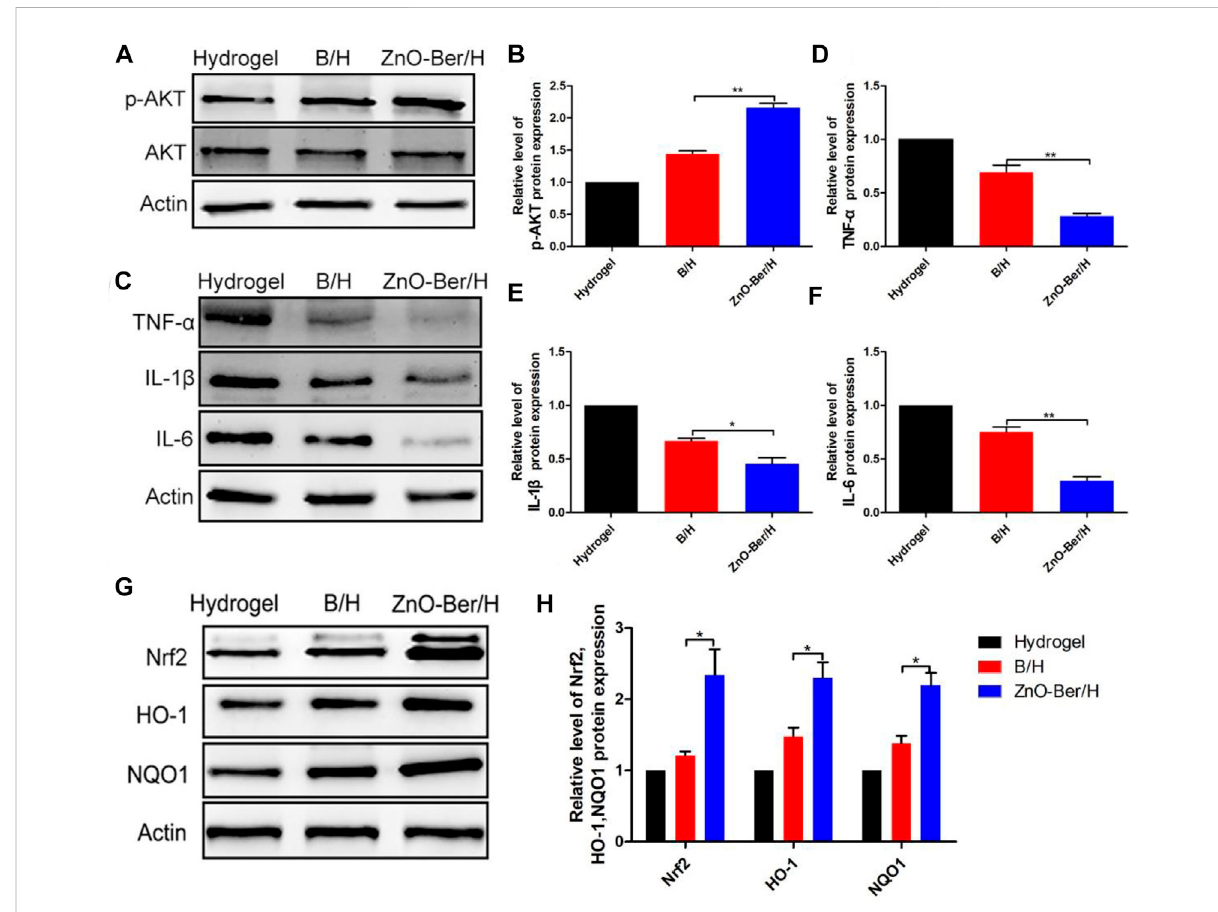
FIGURE 7 Protein expression of In fl ammatory and anti-oxidant stress related factors. (A) Western blot detection of expression of total AKT and p-AKT proteins. (B) TherelativeexpressionanalysisoftotalAKTandp-AKT. (C) WesternblotexpressionofNrf2,HO-1andNQO1proteins. (D – F) Therelative expression analysis of Nrf2, HO-1 and NQO1. (G) Western blot expression of TNF- α , IL-1 β and IL-6 proteins. (H) The relative expression analysis of TNF- α , IL-1 β and IL-6. Statistical analysis: *p ≤ 0.05, **p ≤